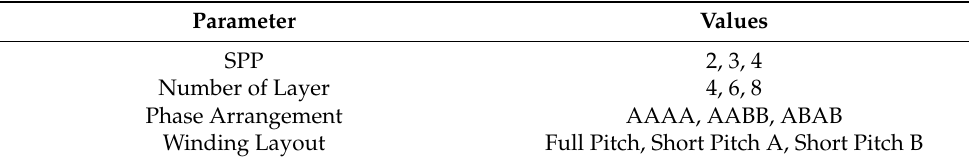
Table 2. Summary of key design parameters for baseline machines.